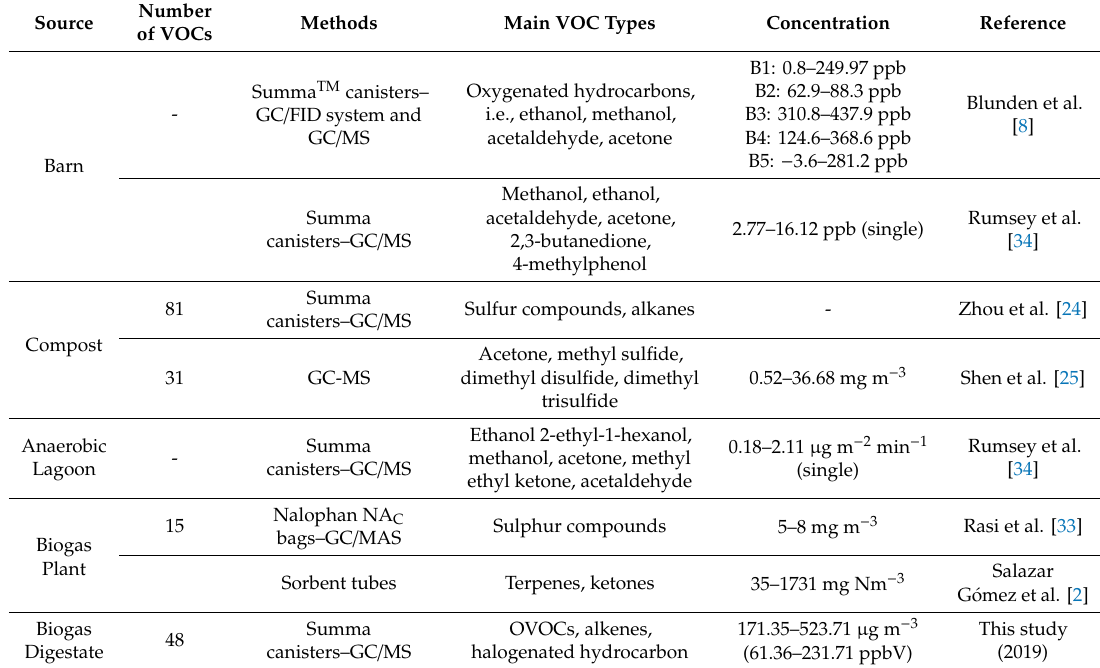
Figure 2. Species and concentrations of volatile organic compounds (VOCs) detected during the biogas digestate storage. Table 3. VOC emissions of livestock production and manure management as reported in literature.